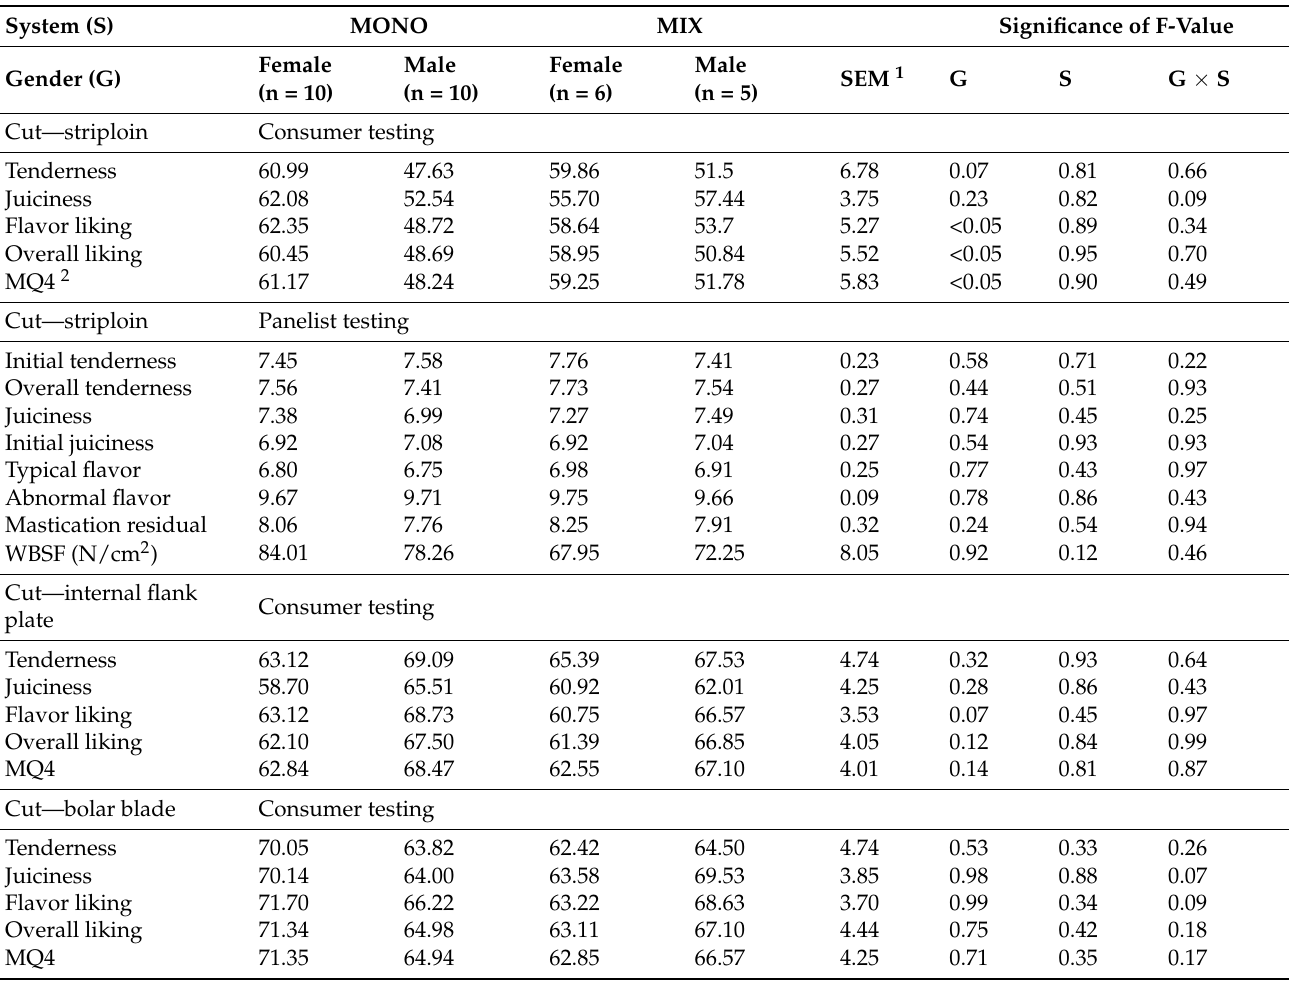
Table 4. Estimated marginal means of eating quality scores evaluated by untrained consumers and trained panelists and WBSF as affected by animal gender and farming